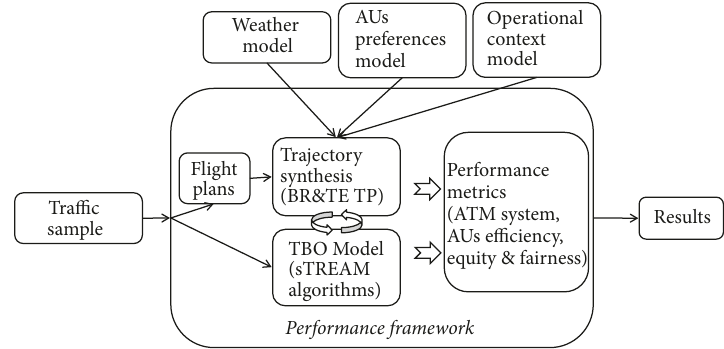
Figure 2: Simulation and optimization tools architecture.